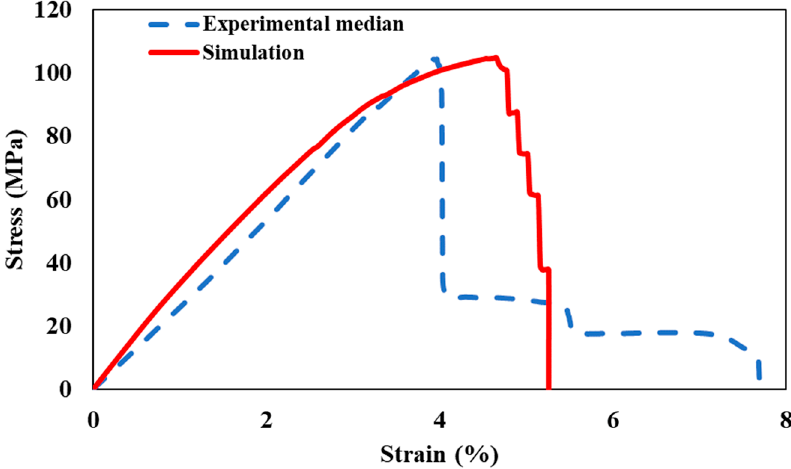
Figure 11. Comparison of stress-strain curves of multi-angled 3D-printed GFRP composite specimens, as observed experimentally and as simulated using the finite element model. Experimental observation represents the median specimen. All results are shown in Figure 7 and presented in Table 5.